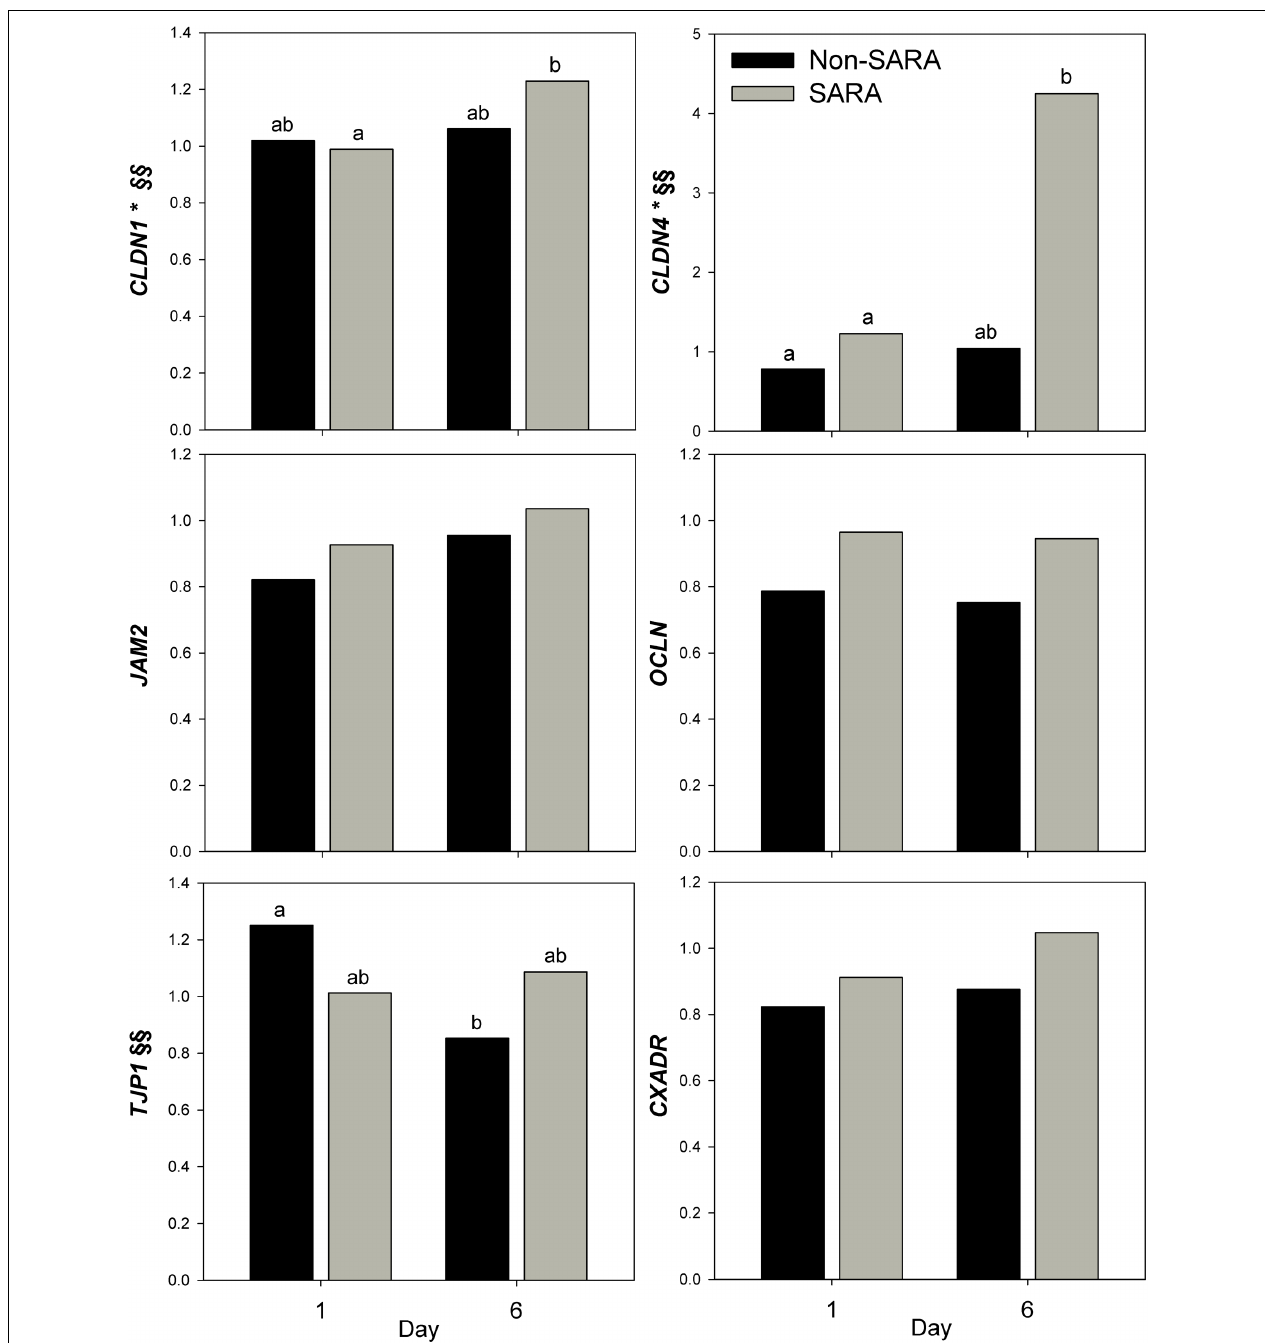
FIGURE 6 | Effect of SARA induction on barrier function gene expression in rumen epithelium tissue. Effects ( P ≤ 0.05) are indicated by symbols: day effect ( ∗ ), treatment effect (#), treatment × day effect (§), and period effect ( ‡ ). Tendencies ( P ≤ 0.1) are indicated by symbols: day effect ( ∗∗ ), treatment effect (##), treatment × day effect (§§), and period effect ( ‡‡ ). Subscripts indicate pairwise differences of P <